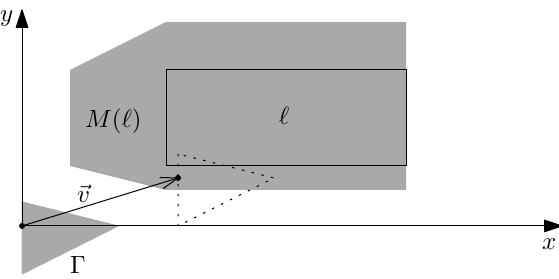
Figure 4. A label (cid:96) , a region Γ , and the region M ( (cid:96) ) = (cid:96) ⊕ − Γ . The definition of M ( (cid:96) ) implies that translating Γ with a vector (cid:126) v ∈ M ( (cid:96) ) yields a region intersecting (cid:96) .